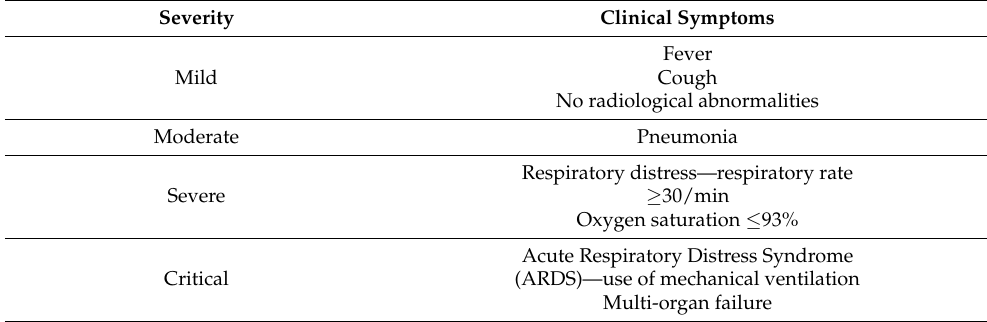
Table 1. SARS-CoV-2 severity and clinical